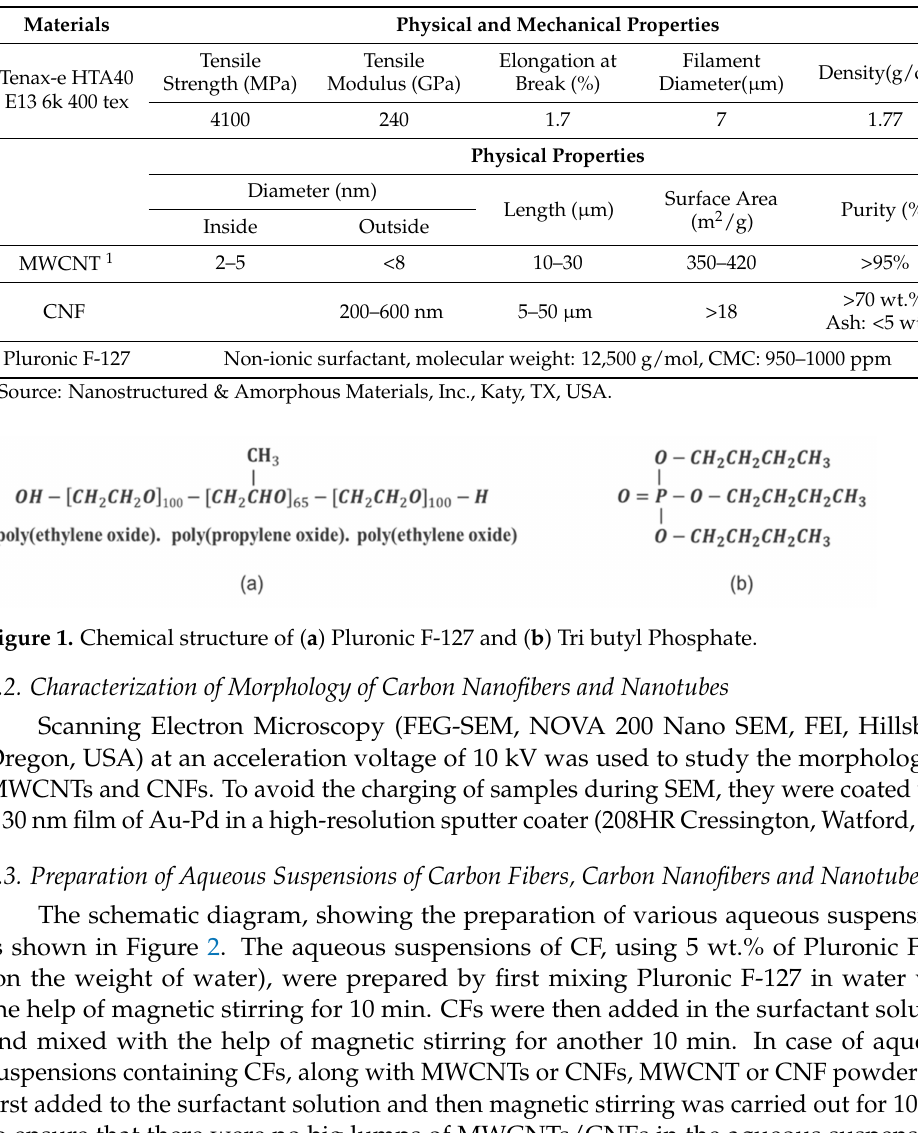
Table 2. Properties of carbon fibers, CNFs, MWCNTs, Pluronic F-127 and defoamer.